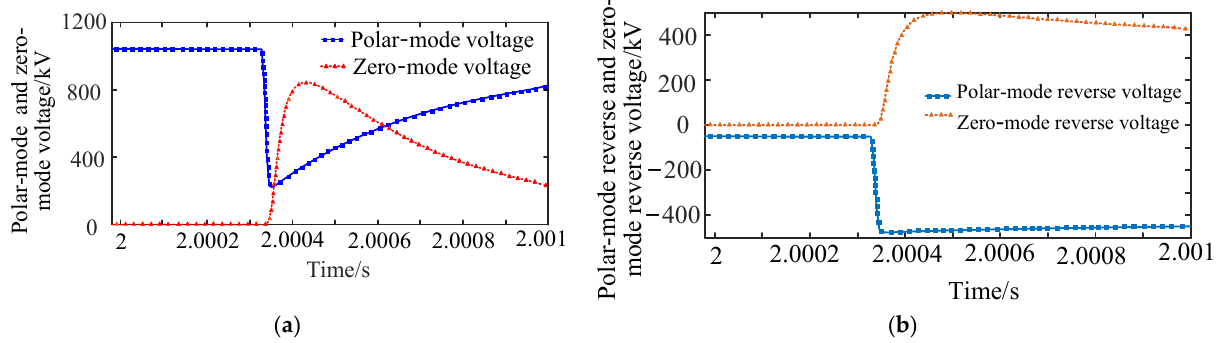
Figure 11. Negative metal grounding short-circuit fault result: ( a ) polar-mode and zero-mode voltage waveforms. ( b ) Traveling wave waveforms of polar-mode reverse and zero-mode reverse voltage.